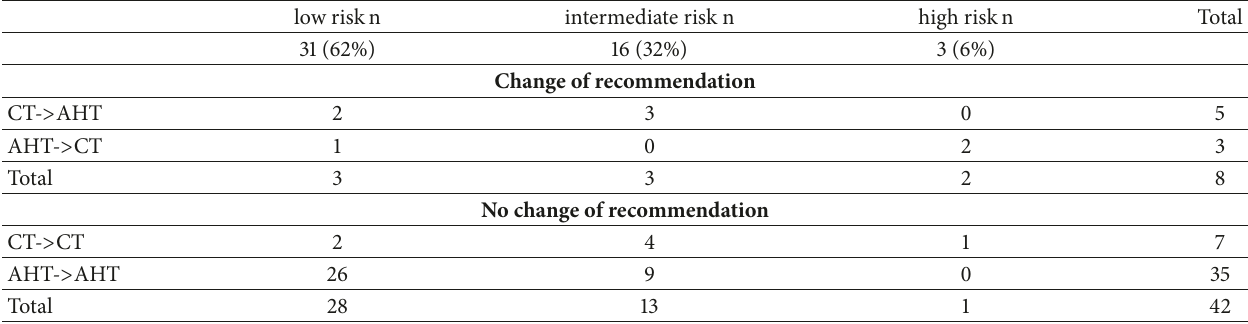
Table 3: Modified recommendation for therapy after results of Oncotype DX (CT = adjuvant chemotherapy; AHT = antihormonal therapy).